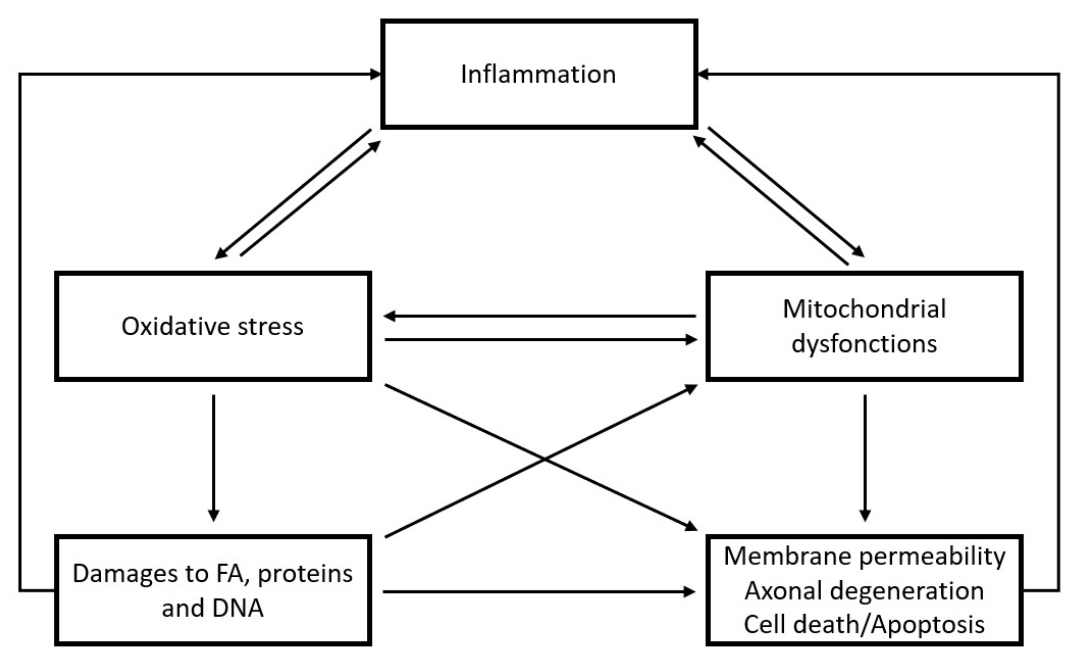
Figure 3. A simplified representation of oxidative stress involvement in the physiopathology of MDD. MDD is related to a dysregulation of oxidative stress with reduced total antioxidant capacity and increased total oxidant status. This oxidative “distress” induces a (neuro-)inflammation, mitochondrial dysfunctions and damage to fatty acids (FA), DNA and proteins. It leads to cell death, axonal degeneration, alterations of membrane permeability, and thus to neurodegenerative processes and brain modifications that are associated with unipolar depression.